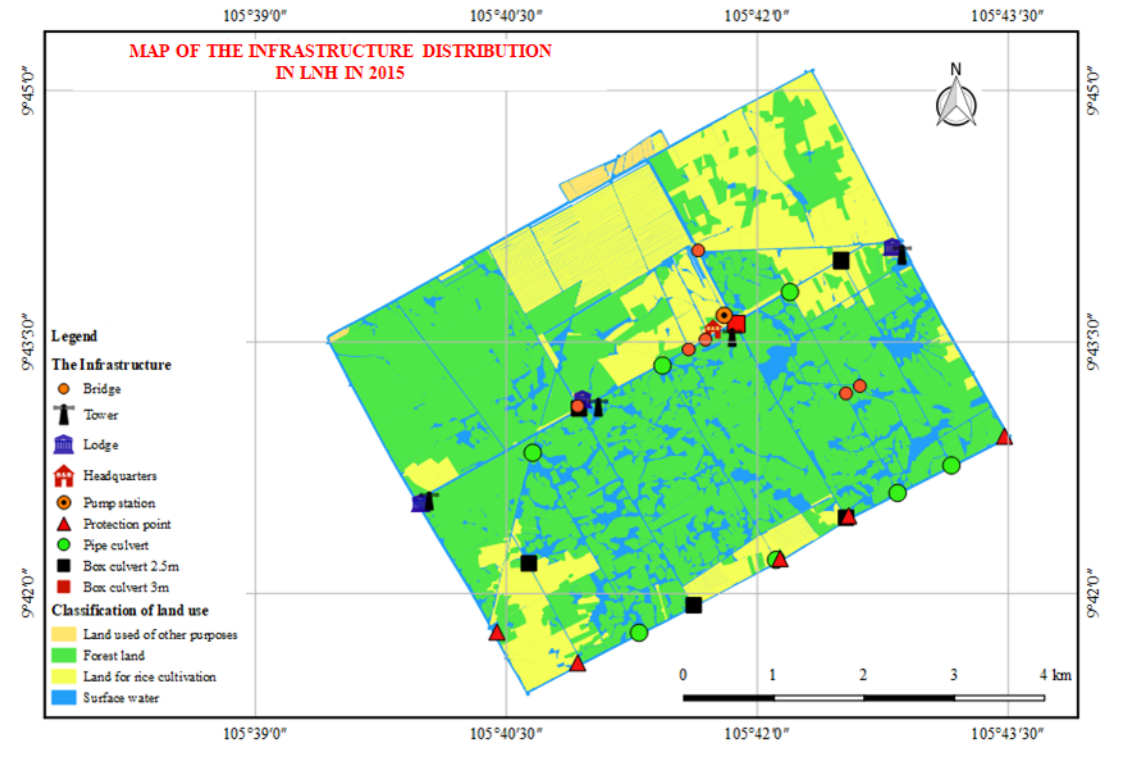
Figure 4. Infrastructure distribution in LNHNR in 2015.